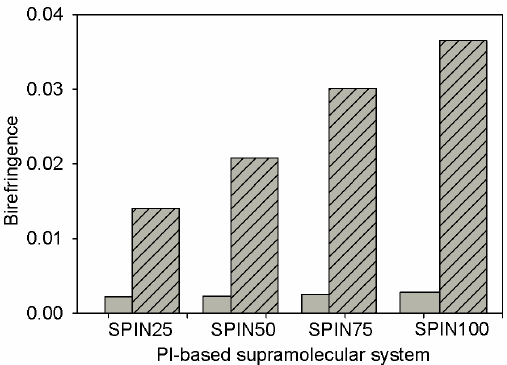
Figure 12. Birefringence of the PI-based supramolecular systems with AzoCN content before and after laser exposure. The bar containing a pattern represents the laser-exposed samples.